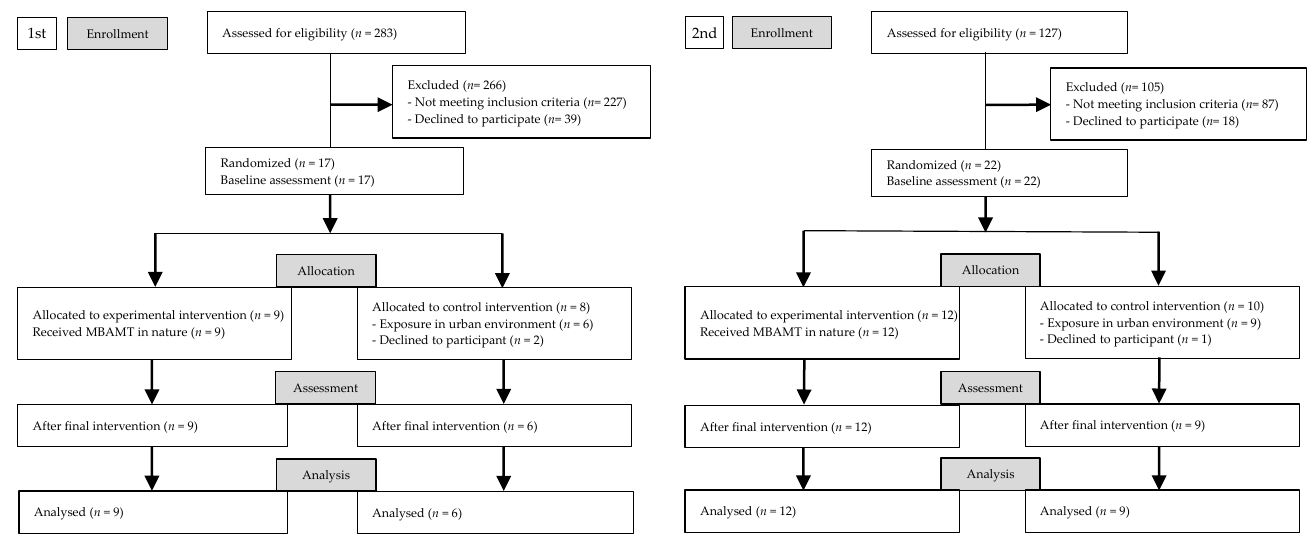
Figure 2. CONSORT flow diagram of first and second experiment. Table 2. Demographic characteristics of the experimental and control